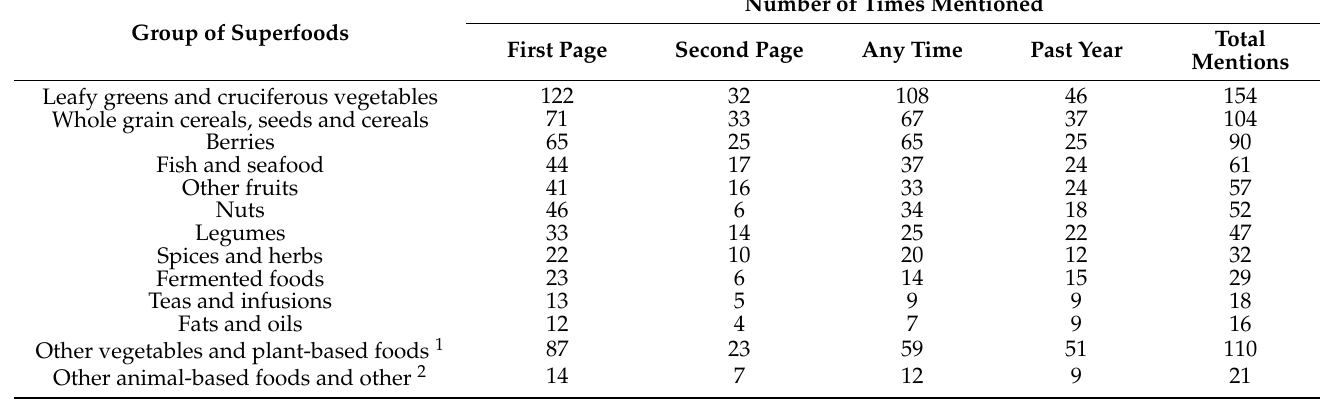
Table 1. Classification of the groups of superfoods by the number of times that were mentioned in selected web